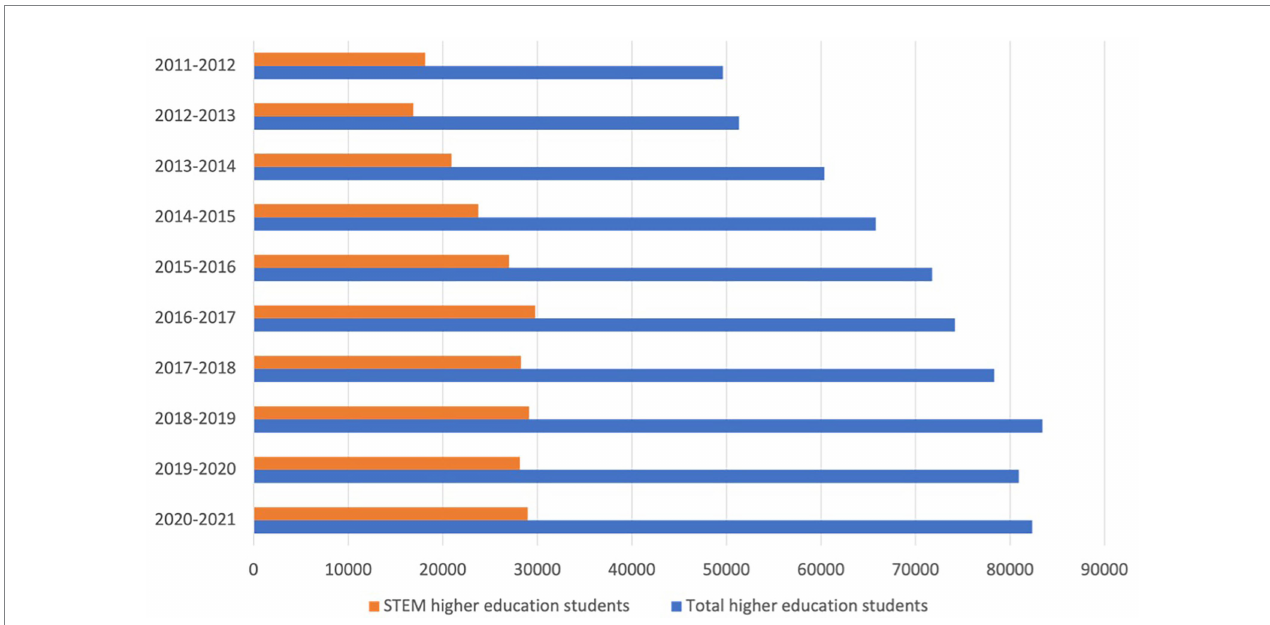
FIGURE 3 Enrollment of students in higher education and STEM degrees in the State of Queretaro by year. Own elaboration based on ANUIES, 2022.